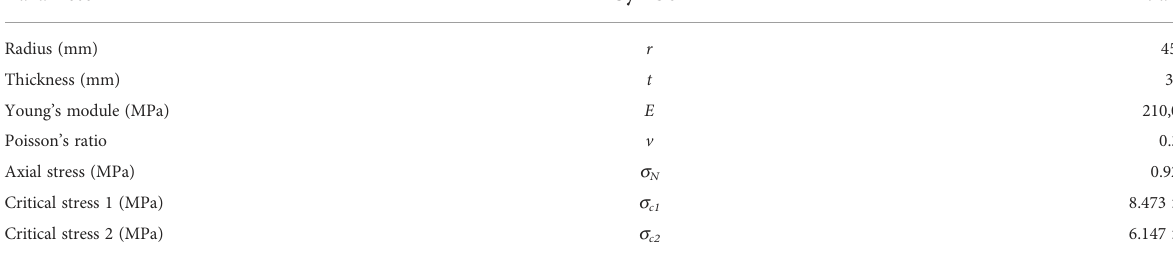
TABLE 3 The parameters for stability analysis during